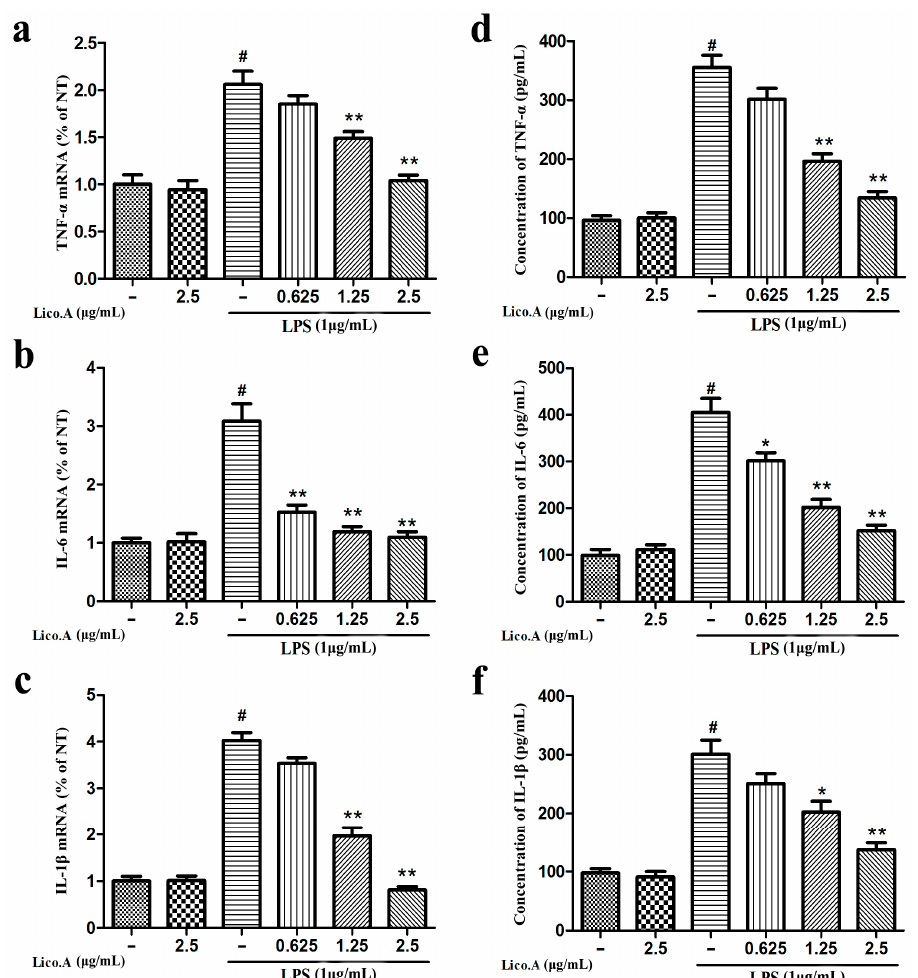
Figure 2. Lico.A inhibits the production of tumor necrosis factor- α (TNF- α ), interleukin-1 β (IL-1 β ) and interleukin-6 (IL-6) in LPS-stimulated BV-2 cells. ( a – c ) The mRNAs levels of TNF- α , IL-6 and IL-1 β were examined by RT-PCR. ( d – f ) Extracellular levels of TNF- α , IL-6 and IL-1 β in culture media were measured with commercial ELISA kits. All the experiments were repeated at least three times and similar results were observed. Values are mean ± SE, ( n = 5 samples/group). # p < 0.01 vs. NT group; * p < 0.05, ** p < 0.01 vs. LPS group.